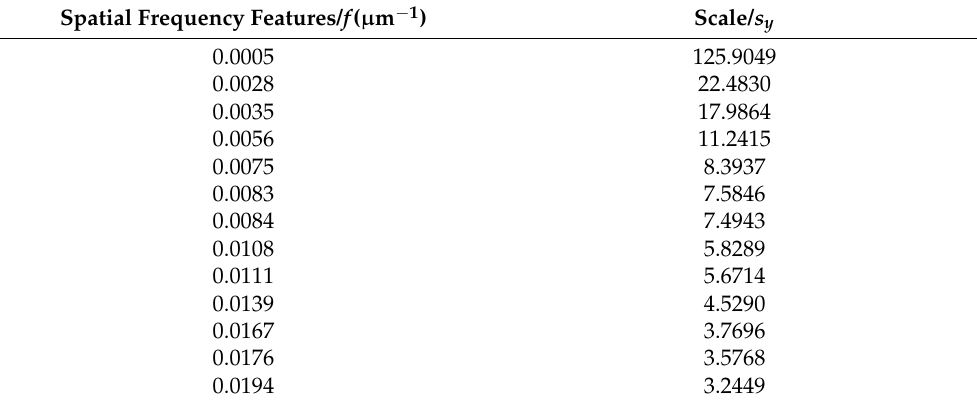
Table 4. CWT calculation parameters of the spatial frequency features in the Y